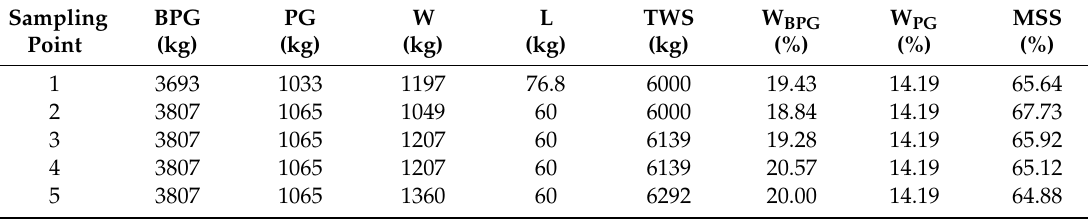
Table 2. Monitoring results of dihydrate-hemihydrate phosphogypsum filling slurry preparation 1 .